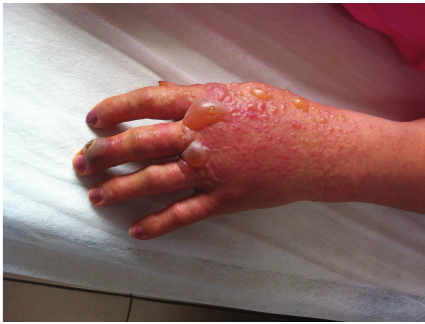
Figure 2: Vesiculobullous lesions, the first day of admission.